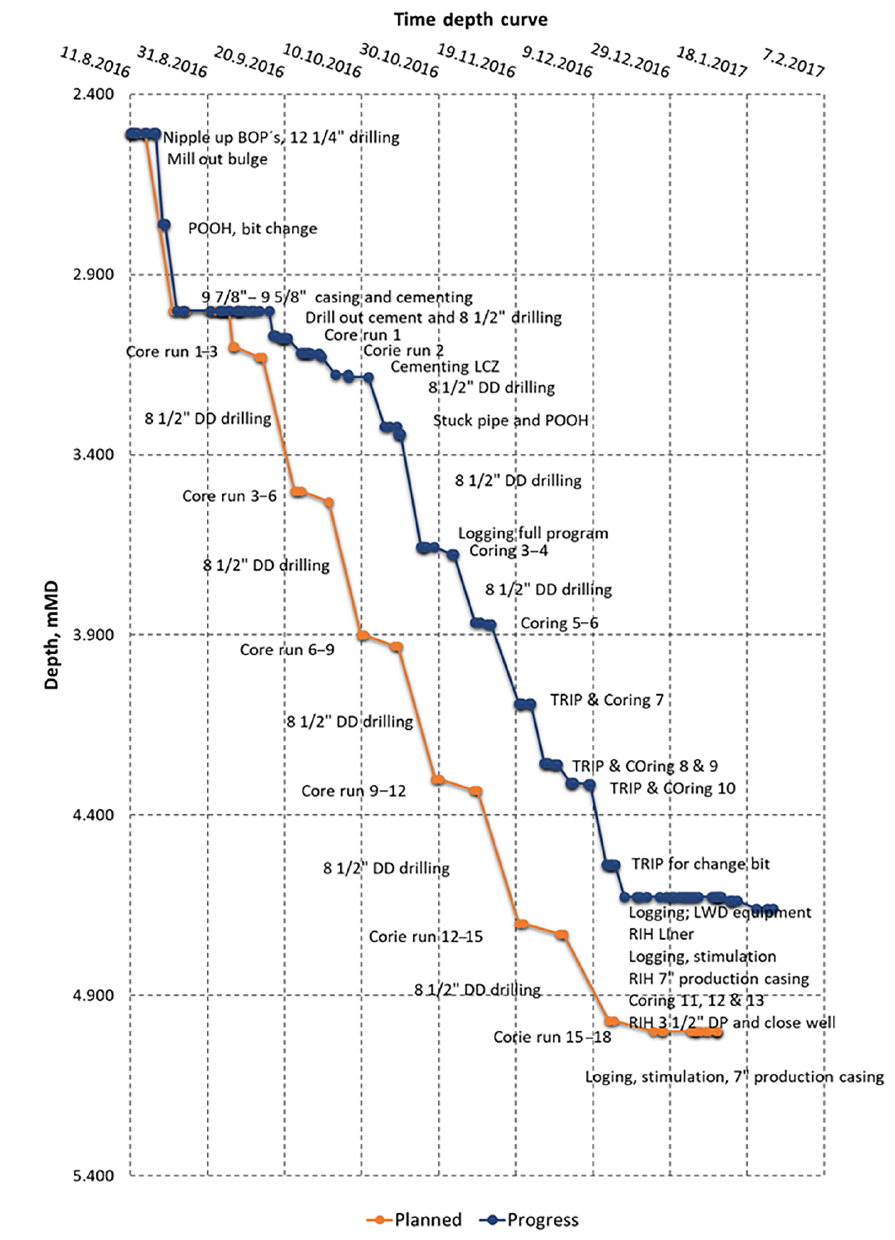
Figure 4. Actual drilling progress of the RN-15/IDDP-2 drill hole (blue) compared to the drilling schedule (orange).